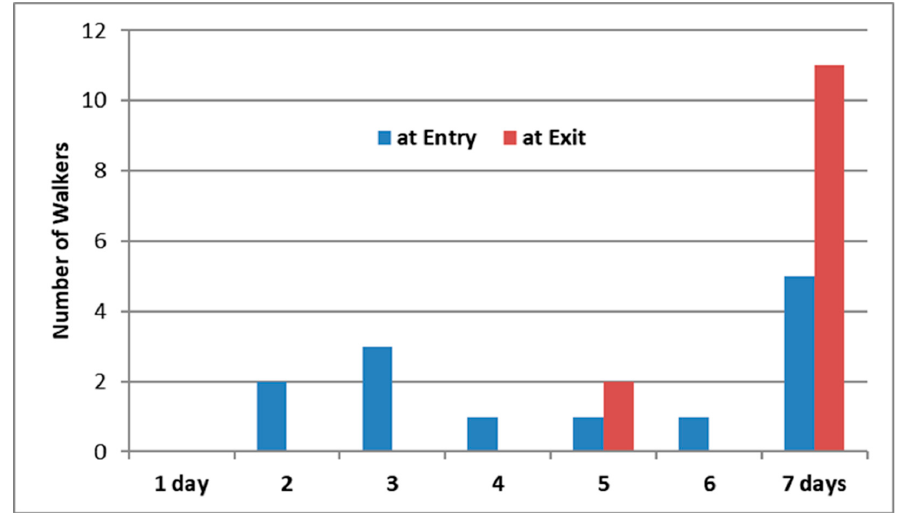
Figure 2. Number of physically active days in a week at entry and at the end of a 12-week activity tracker group outdoor health walk ( n = 13 walkers). Question asked: ‘In the past week, on how many days have you been physically active for a total of 30 min or more? Physical activity may include: walking or cycling for recreation or to get to and from places; gardening; and exercise or sport which lasts for at least 10 min’.